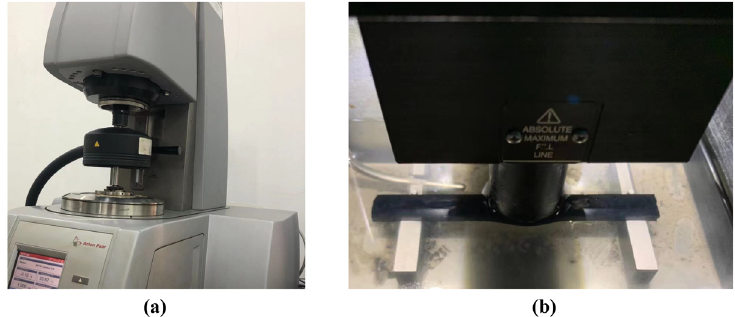
Figure 18: DSR and bending beam rheometer ( BBR ) test: ( a ) dynamic shear rheological test and ( b ) fl exural creep sti ff ness